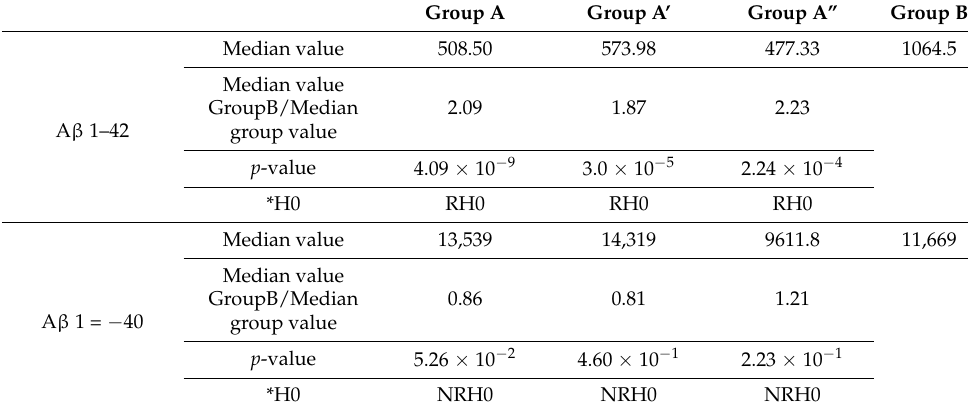
Table 7. Mann-Whitney medians’ media evaluation test. The ratio of the mean of the medians of Group B respect the values of each Group A (A, A’ and A”) was evaluated together with the p -value. For the hypothesis H0 = Null hypothesis (equality of the values of the two analyzed groups) this was rejected for p <